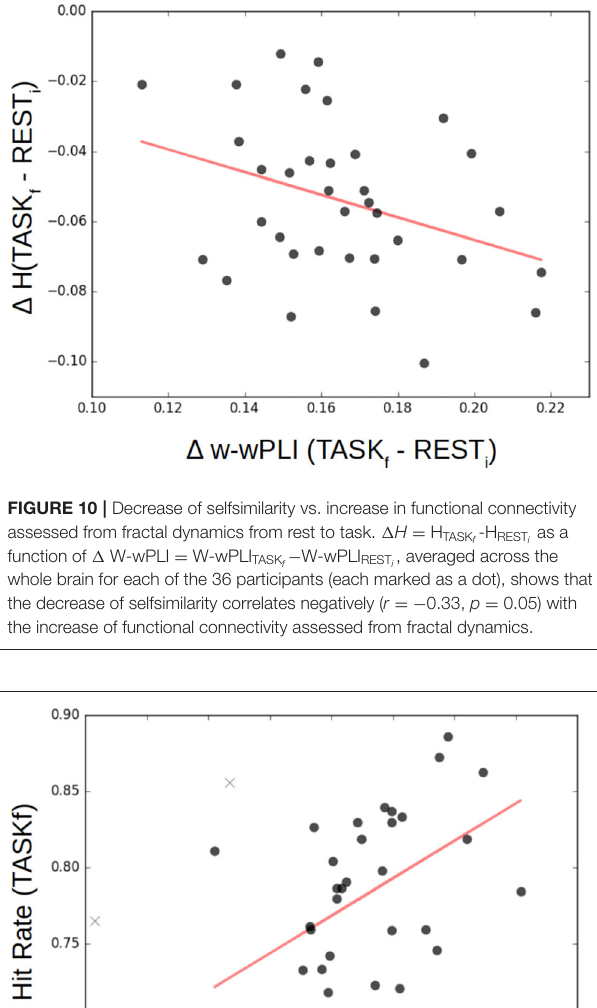
FIGURE 11 | Functional connectivity assessment from fractal dynamics vs. Task Performance. Individual performance in the post-training task shows significant ( p = 0.01) positive correlation ( r = 0.45) with the difference in functional connectivity assessed from fractal dynamics from pre- to − W-wPLI TASK post-training, i.e., W-wPLI TASK . Each participant is f i represented as a dot, and outliers are marked with a ×